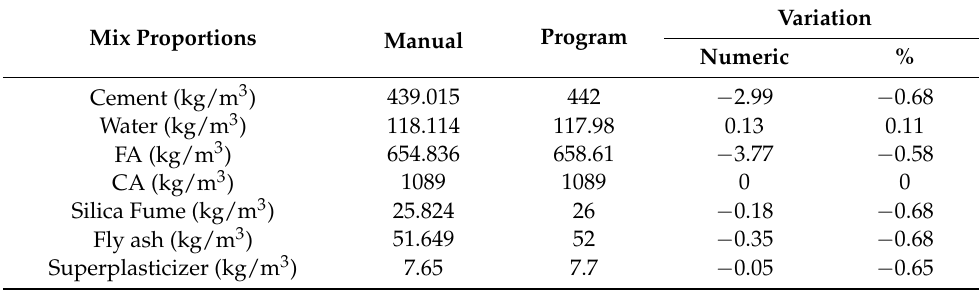
Table 2. A comparison between manual calculations and program outputs for Aïtcin method [35].